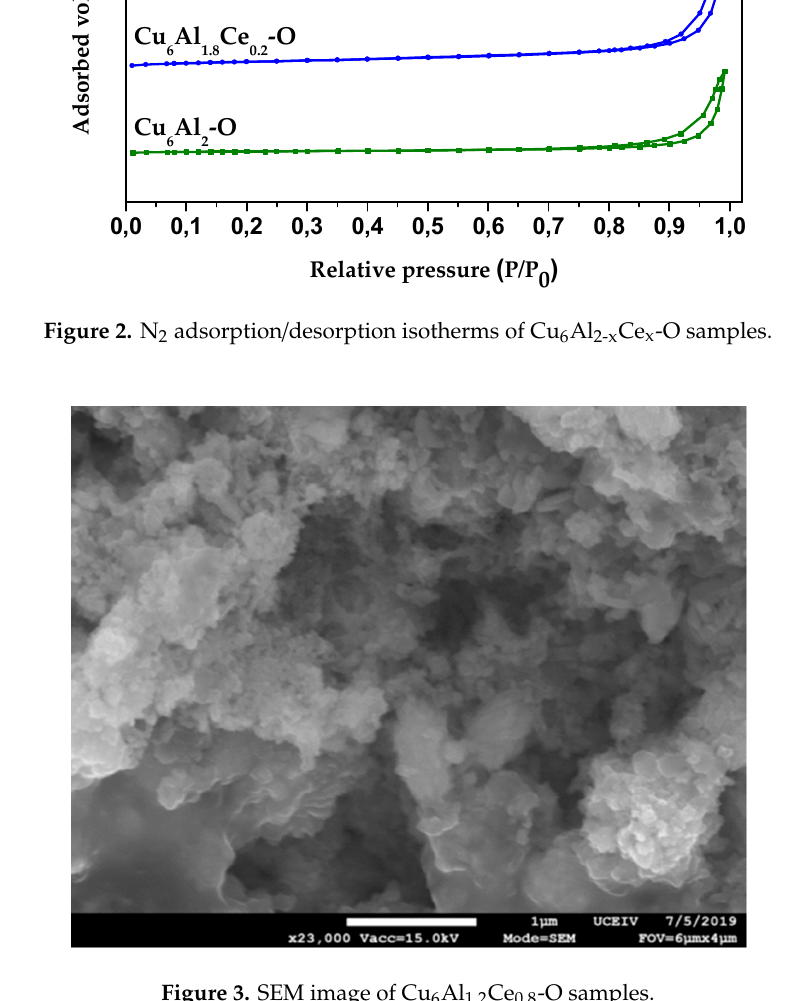
6 Al 1.2 Ce 0.8 -O